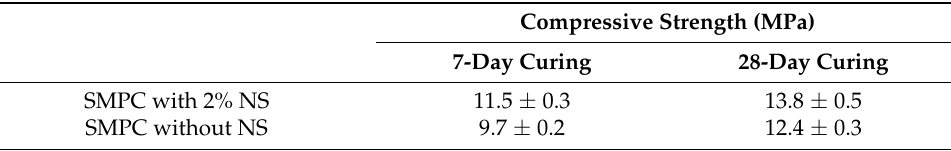
Table 3. Preliminary results of the compressive strength of SMPCs with and without the addition of NSa. The data shown are the averages with standard deviations ( n =